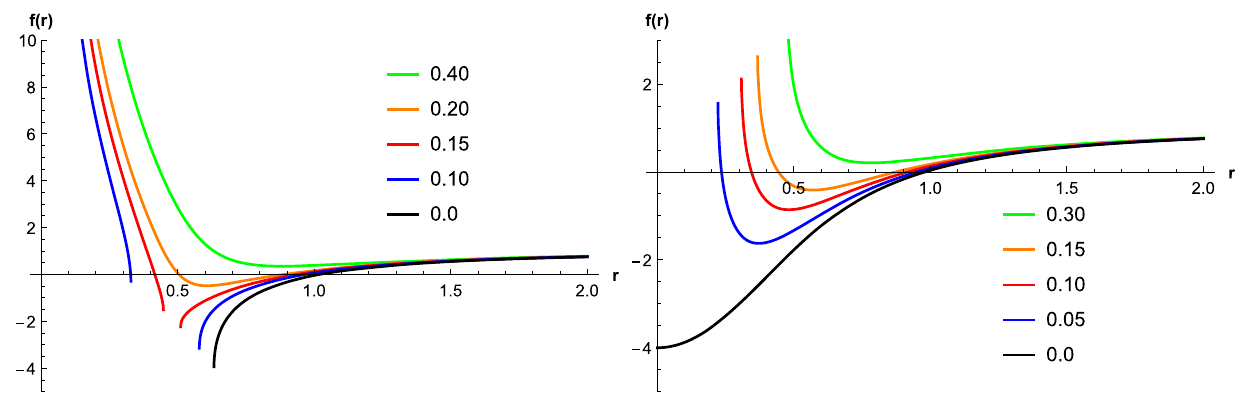
Fig. 2 Horizon and singularity structure of charged Gauss–Bonnet black